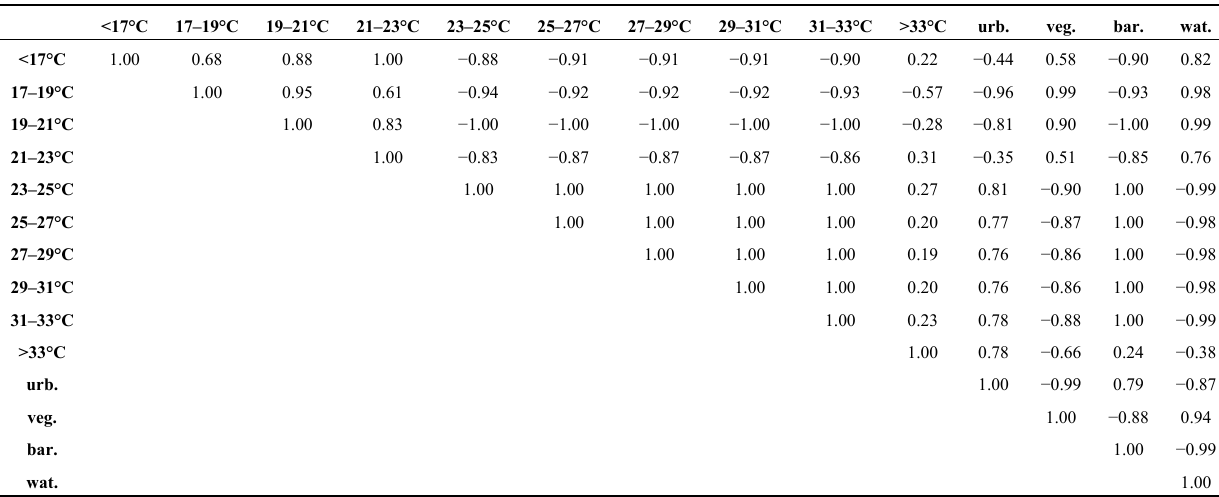
Table 1. Correlation matrix of changes in temperature and land cover classes during the analyzed time